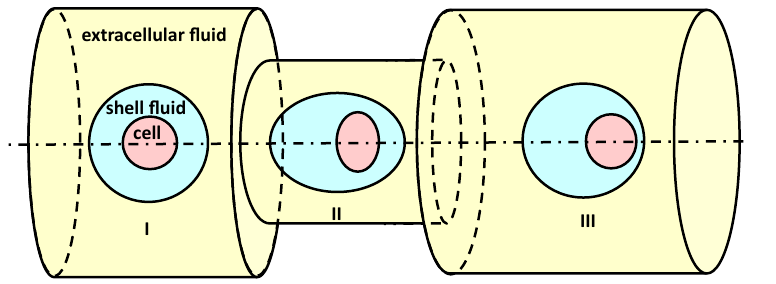
Figure 1. The schematic illustration of cell-laden droplet passing through a constricted